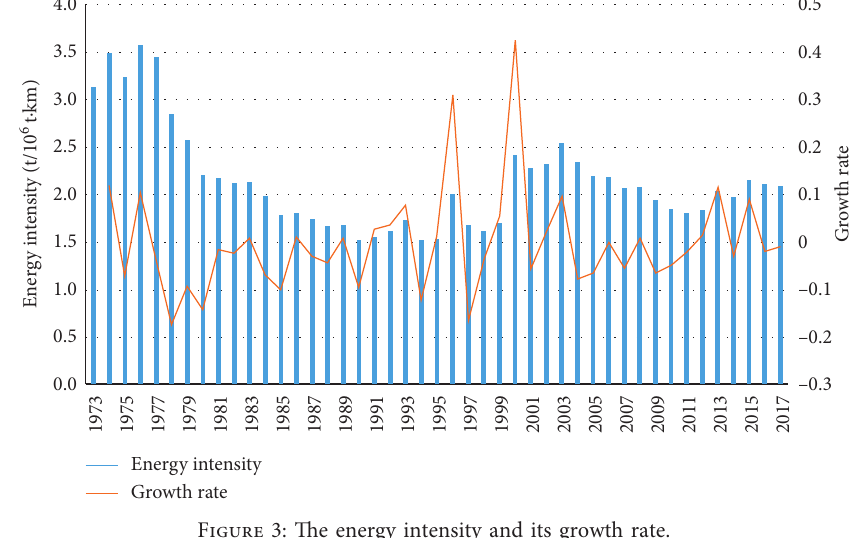
Figure 3: The energy intensity and its growth rate.